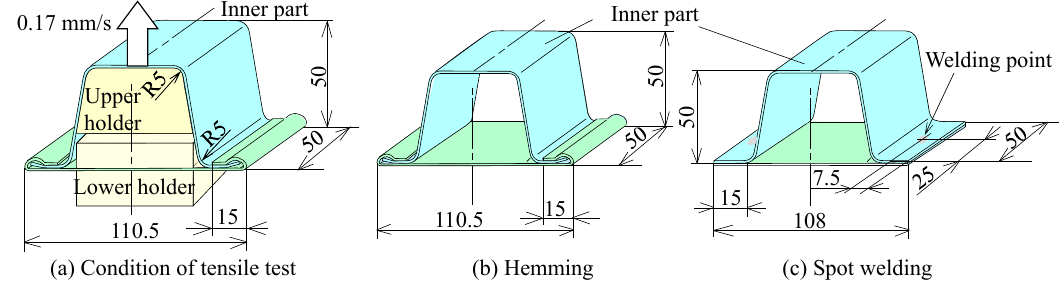
Figure 14. Conditions and geometries of specimen in tensile test.